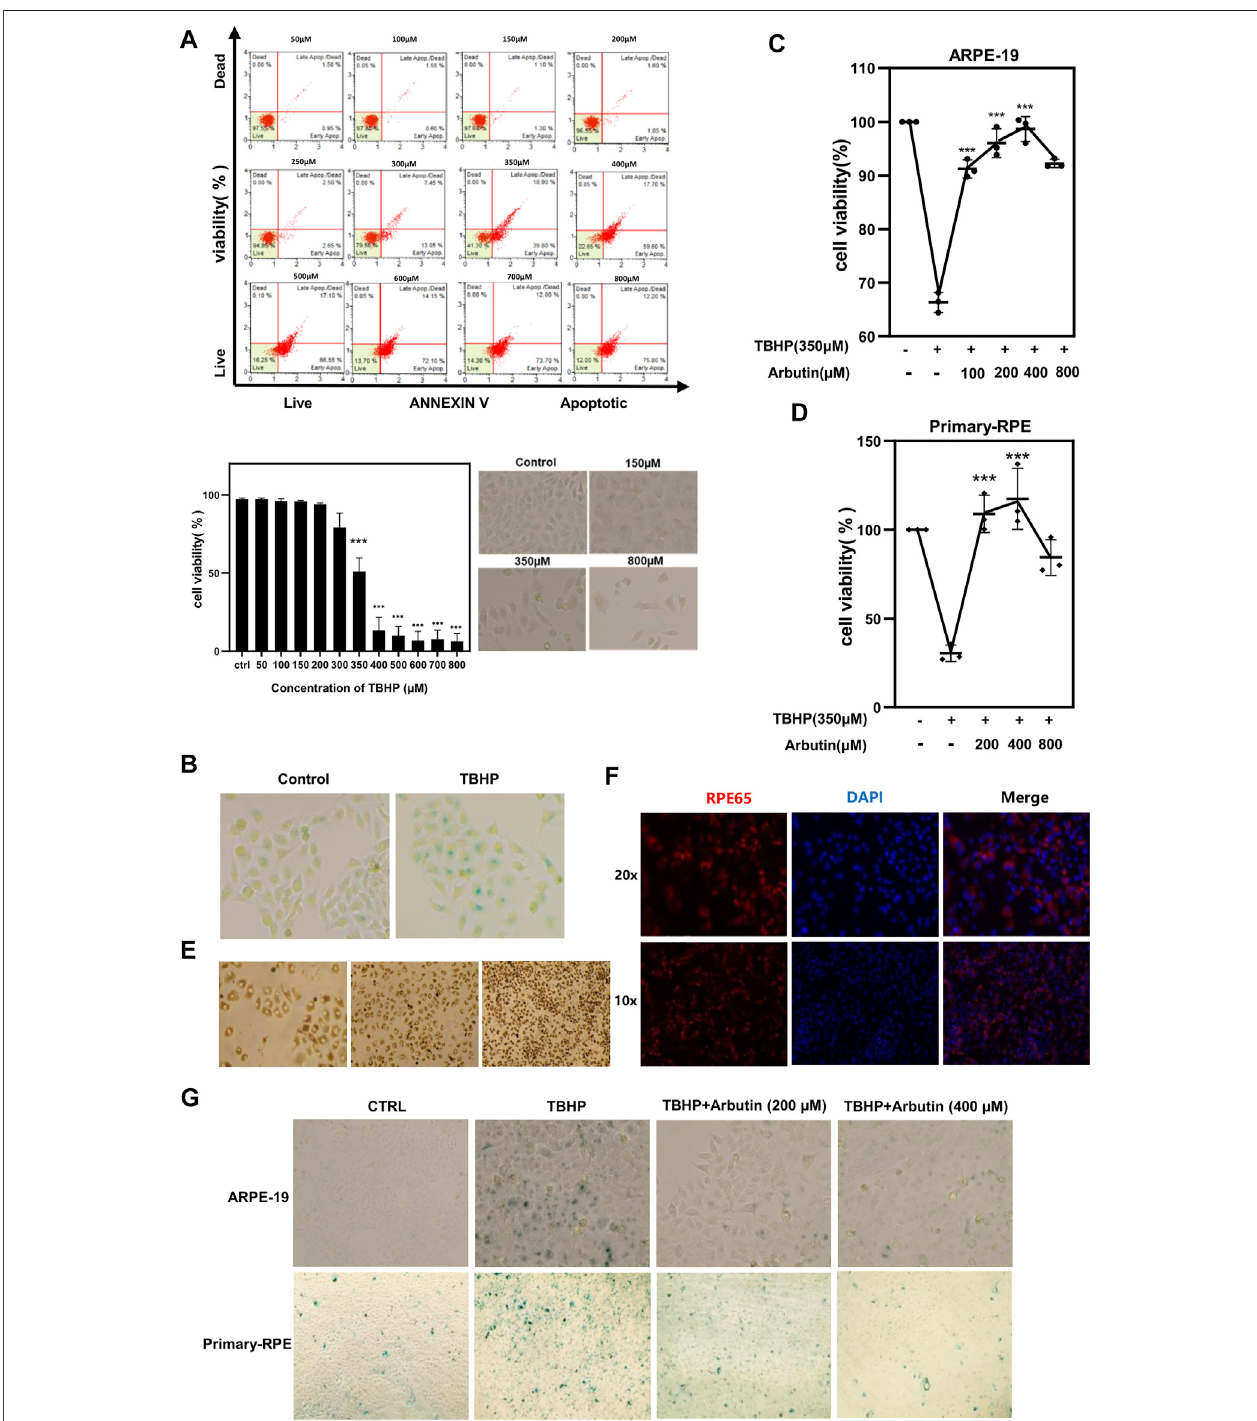
FIGURE 1 | Arbutin protected retinal pigment epithelium (RPE) cells from tert-butyl hydroperoxide (TBHP)-induced senescence and apoptosis. (A) RPE cells were treated with different concentrations of TBHP ranging from 50 µM to 800 µM for 24 h and cell viability was determined with Annexin V & Dead. TBHP inhibited RPE cell viability and the apoptosis ratio showed a statistical difference at a concentration of 350 µM. RPE cell morphology displayed abnormality under a microscope at concentrations of 150, 350, and 800 µM. (B) 350 µM TBHP treatment for 24 h upregulated SA- β -Gal activity in RPE cells. (C) fl ow cytometric analysis and (D) CCK8 assay respectively showed that Arbutin pretreatment rescued ARPE-19 and primary-RPE cells from TBHP-induced apoptosis in a concentration-dependent